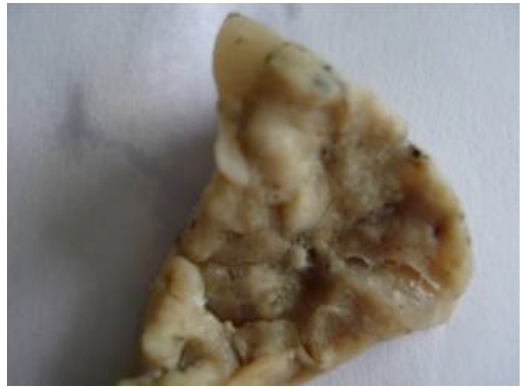
Image 5. Lung of Striped Hyena showing minute nodules and numerous black clumps coloration all over parenchyma